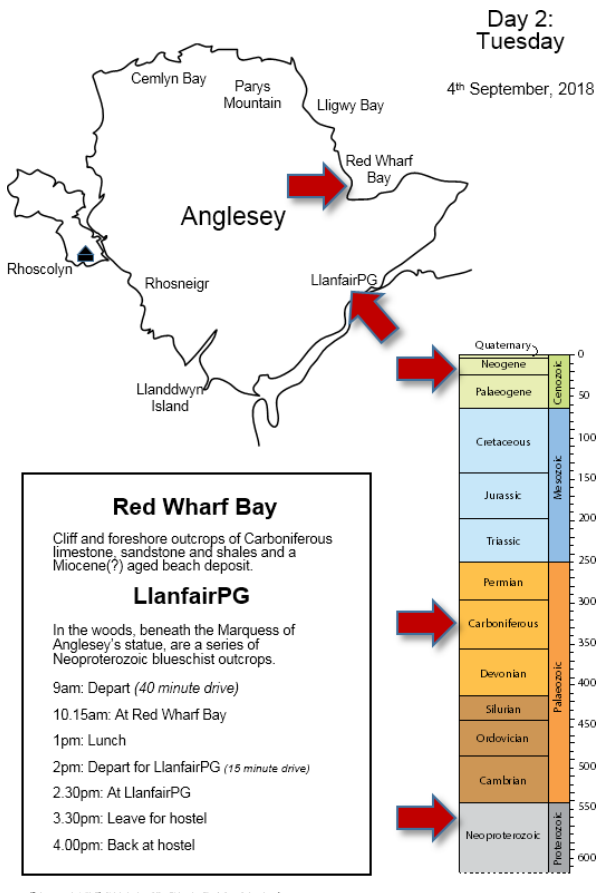
Figure 2. Example of a handout front page showing the schedule and localities for the day, including a brief description and age. Map redrawn from © OpenStreetMap contributors 2019. Distributed un- der a Creative Commons BY-SA